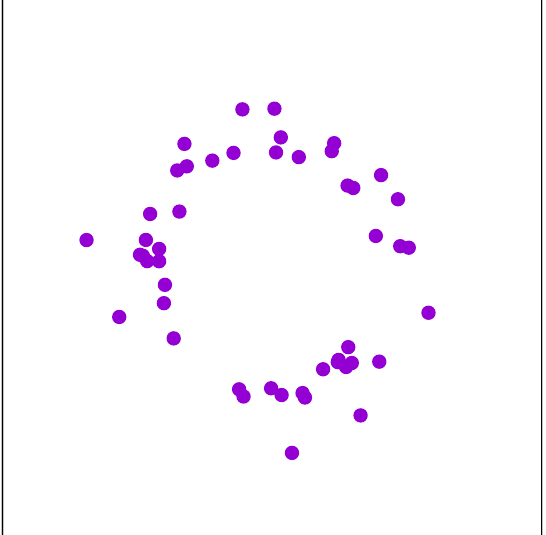
Figure 6. Stadium distribution.